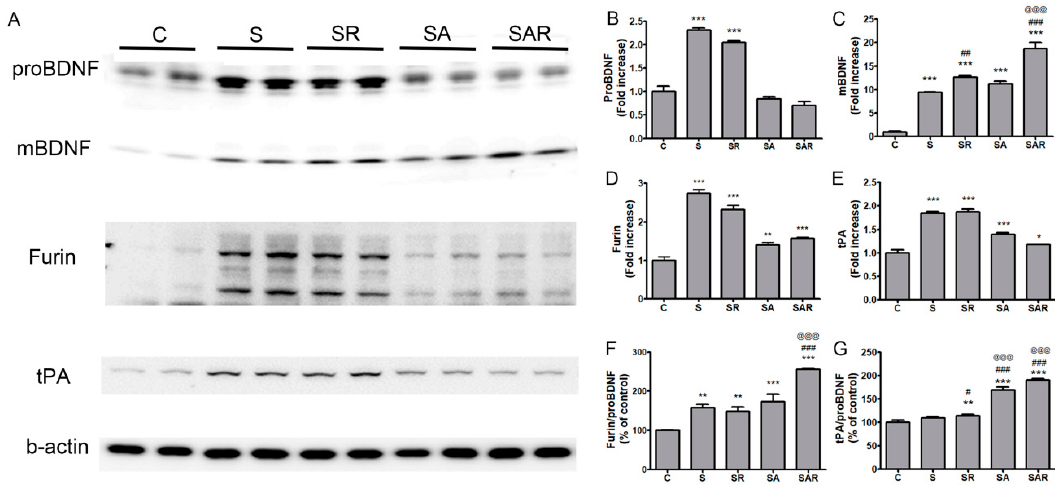
Figure 7. Effect of TST and TST combined with 5-Aza-dC treatment on the expression of mature BDNF in protein extracts of contralesional cortex after stroke. ( A ) Representative photomicrographs of western blots for pro-brain-derived neurotrophic factor (proBDNF), mature BDNF (mBDNF), furin, tissue plasminogen activator (tPA), and β -actin in total lysates of the contralesional cortex at 4 w after post-stroke treatment. ( B – E ) Signal intensities of proBDNF, mBDNF, furin and tPA were measured using Quantity One software and are shown as a percentage of control. ( F , G ) Signal intensities of the ratio of furin to proBDNF and tPA to proBDNF are shown as a percentage of control. Beta-actin, internal control. Results are presented as the mean ± SE, n = 6. * p < 0.05; ** p < 0.01; *** p < 0.001 vs. C, # p < 0.05; ## p < 0.01; ### p < 0.001 vs. S, @@@ p < 0.001 vs. SR.